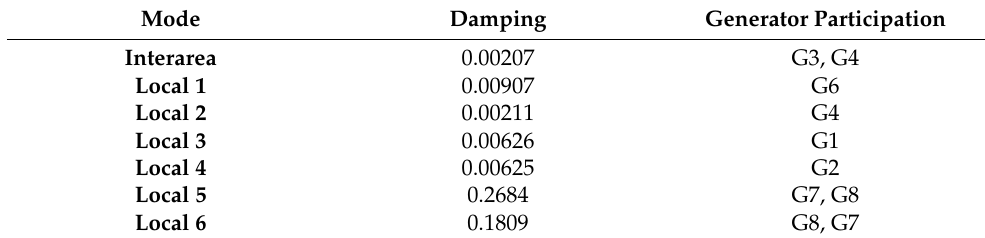
Table 2. Scenarios for simulation studies.